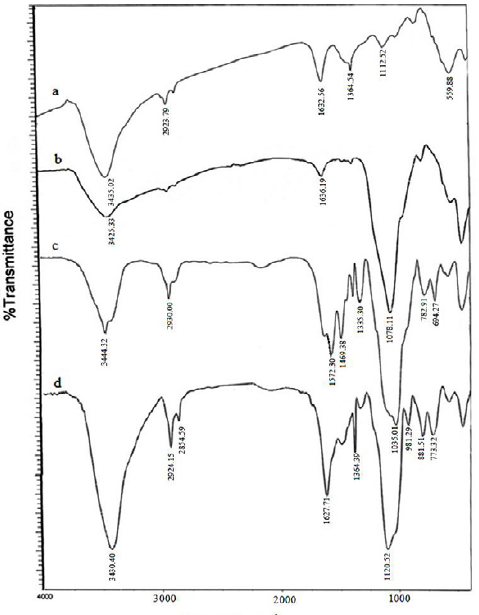
Fig 3. FT-IR of (a) CdFe